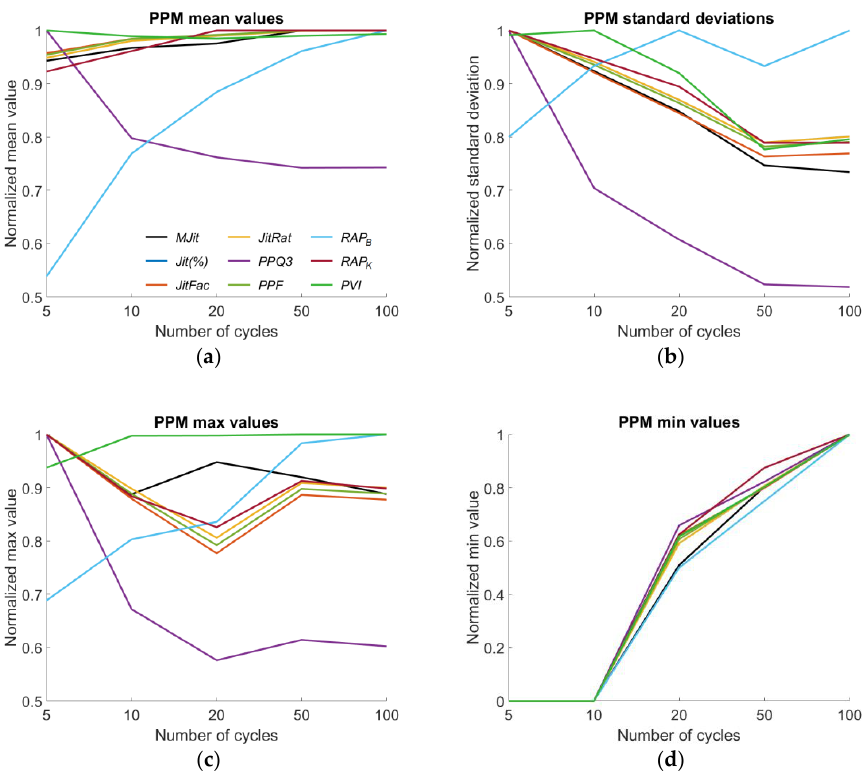
Figure 5. Period Perturbation measures (PPM): ( a ) normalized group means, ( b ) standard deviation, ( c ) maximum value, ( d ) minimum value.